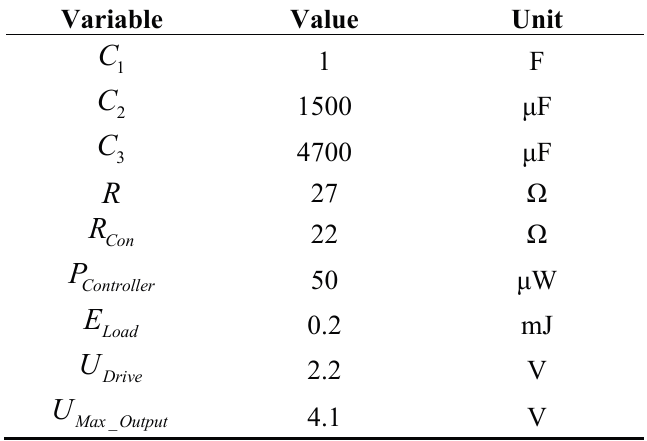
Table 3. Variables used in power management system experiment.